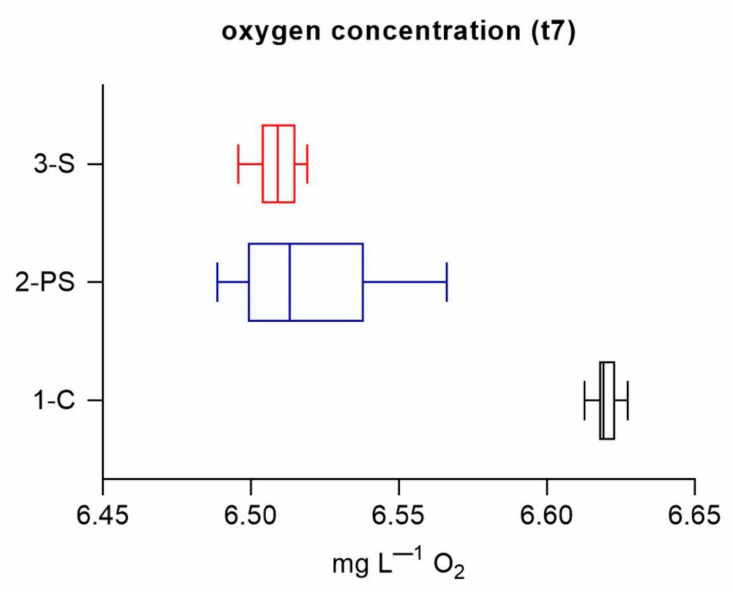
Figure 4. Initial oxygen concentrations per treatment (t7). Per each box plot, n = 200 (50 measurements per cuvette, for 4 replicate cuvettes each treatment). Box plots have the following color code: 1-C (black line), 2-PS (blue line) and 3-S (red